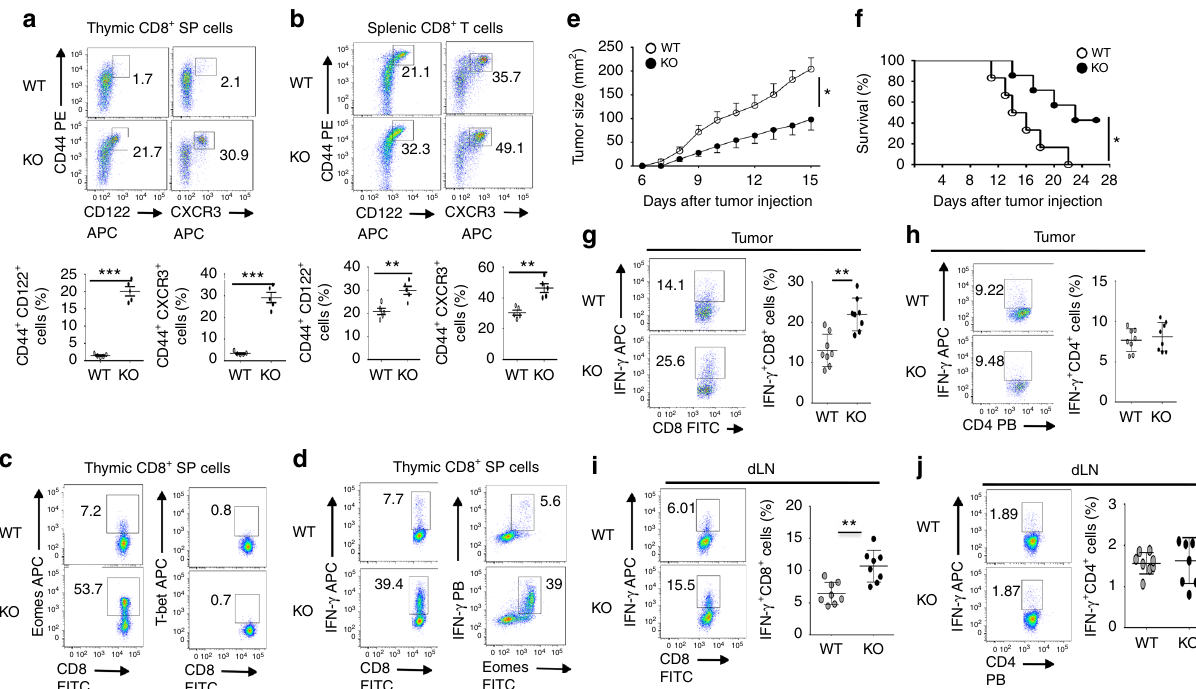
Fig. 3 Tbkbp1 de fi ciency increases the frequency of memory-like CD8 + T cells and antitumor immunity. a , b Flow cytometric analysis of memory-like CD8 + T cells based on expression of CD44, CD122, and CXCR3 surface markers in the CD8 + single positive (SP) thymocytes ( a ) and spleen CD8 + T cells ( b ) derived from 6-week-old WT and Tbkbp1-KO (KO) mice, presented as representative FACS plots (upper) and summary graphs (lower, each circle represents a mouse). c , d ICS analysis of Emoes + and T-bet + cells ( c ) and IFN γ + and IFN γ + Eomes + cells ( d ) in CD8 + single positive (SP) thymocytes. e , f Tumor growth ( e ) and survival ( f ) curves of WT and Tbkbp1-KO (KO) mice injected s.c. with B16-OVA melanoma cells. Lethality was de fi ned as tumor size reaching to 225 mm 2 . n = 8 per genotype group. g – j Flow cytometric analysis of the frequency of IFN γ -producing CD8 + ( g , i ) and CD4 + ( h , j ) T cells in the tumors ( g , h ) or draining lymph node ( i , j ) of WT and Tbkbp1-KO mice injected s.c. with B16-OVA melanoma cells (day 15 after injection), presented as representative plots (left) and summary graphs (right). Data are representative of at least three independent experiments, and bar graphs are presented as mean ± s.d. values. * P < 0.05; ** P < 0.01; *** P < 0.001. Student ’ s t -test ( b , g , i ), Mann – Whitney test ( a , h , j ), Two-way ANOVA ( e ), log-rank Mantel-Cox test ( f